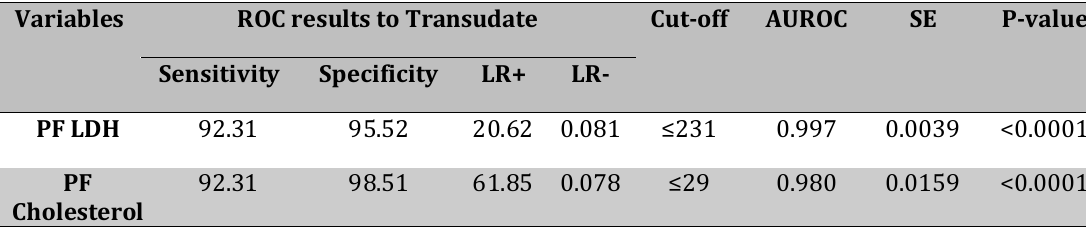
Table 4. Transudative effusions ROC analysis .